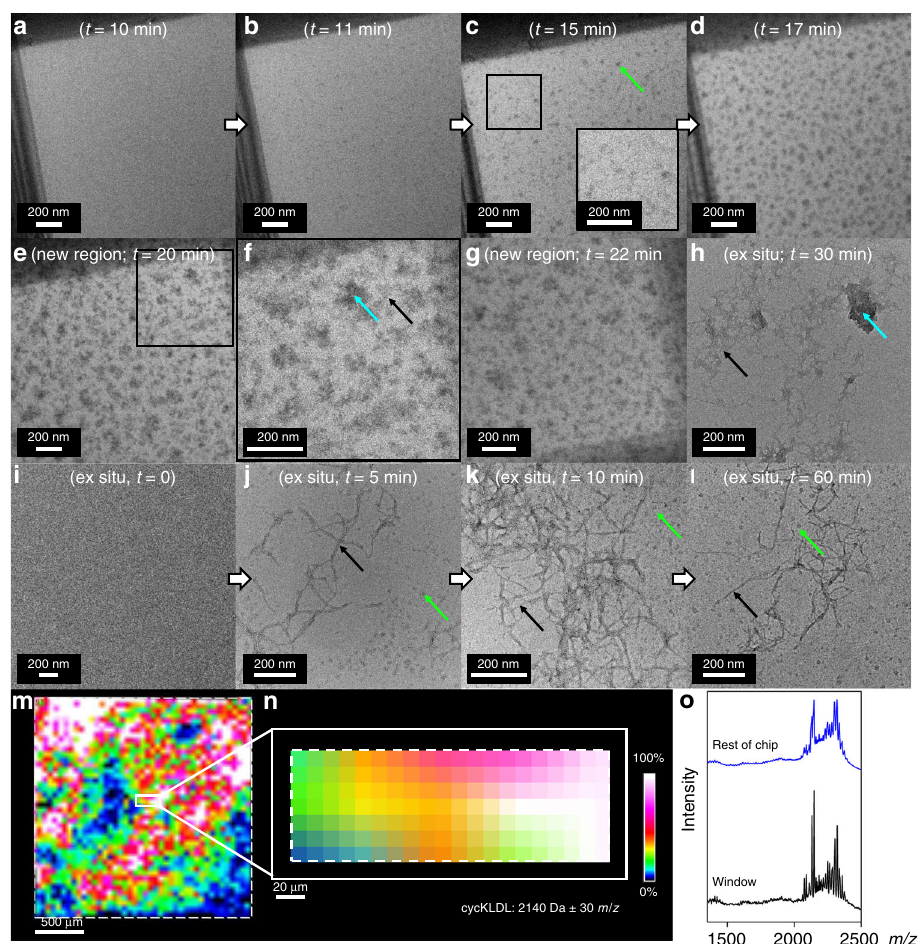
Fig. 7 TCEP activation of cycKLDL to form nanoscale structures in situ and in bulk solution (ex situ). a – d LCTEM images of a solution of cycKLDL and TCEP acquired under low- fl ux, pulsed conditions, where t = 0 corresponds to initial mixing of cycKLDL and TCEP before liquid cell assembly. Inset in c shows zoom-in of boxed region. e Top right corner of the same liquid cell, which had not been previously irradiated. f Zoom-in of the region boxed in e depicting unstained architectures. g Bottom right corner of the same liquid cell, which had not been previously irradiated. h Dry-state image of uranyl acetate-stained architectures generated ex situ from the same reaction solution, which was imaged by LCTEM, with no agitation. i – l Uranyl acetate-stained, dry-state TEM images of cycKLDL and TCEP over a 60 min time period when formed ex situ in a standard test tube with agitation. Nanoparticle (green), aggregated node (blue), and fi ber (black) architectures are denoted with colored arrows. m MALDI-IMS mapping of chip from the LCTEM experiment shown in a – g with fi lter (with manually de fi ned range represented as ±) for cycKLDL applied (2140 ± 30 m/z ). n Zoom-in of MALDI-IMS mapping of the rectangular window shown in m with fi lter for cycKLDL applied (2140 ± 30 m/z ). o Averaged MALDI spectra of window region shown in n (black) and of the rest of the chip surface (blue). Filter colors are displayed as 0 – 100% of integrated intensity on a logarithmic scale within the analyzed region. Source data are provided as